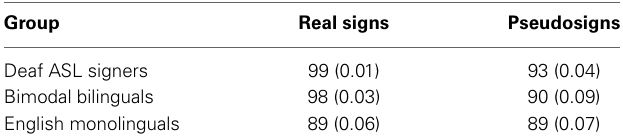
behavioral scores measured in percent correct for the sign repetition task by language